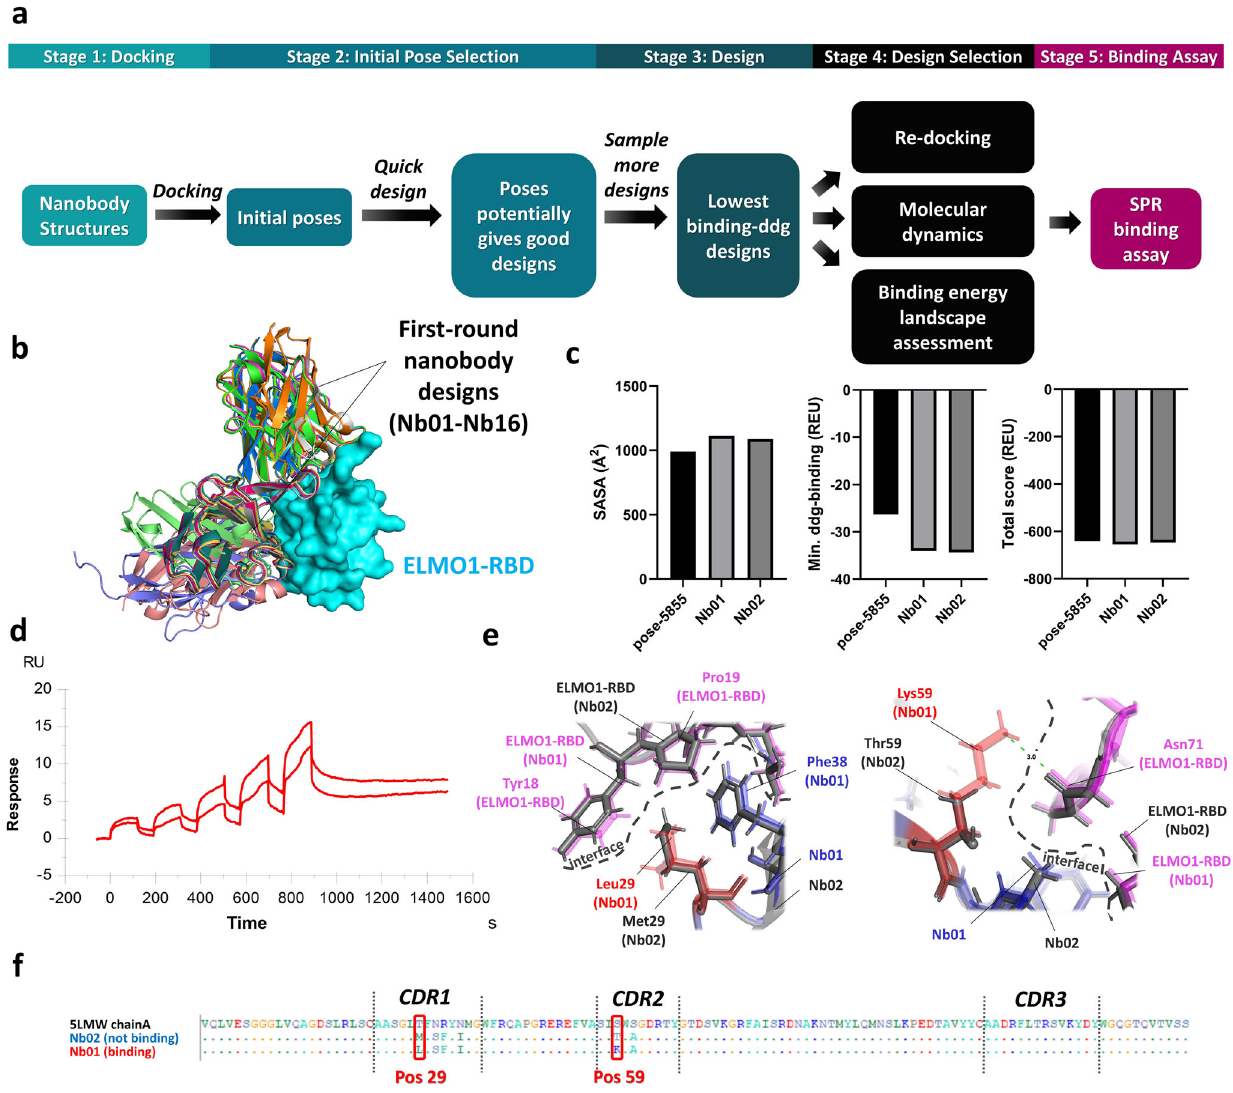
Fig. 2 Computational design and experimental veri fi cation results from fi rst-round design. a Overall design work fl ow in fi rst-round design. b Superposition of fi rst-round nanobody designs revealed the stabilization of two clusters of binding poses on two distinct epitopes on ELMO1-RBD. c Rosetta energy scores and buried solvent accessible area comparisons between designs Nb01, Nb02 and pose-5855. d SPR single-cycle kinetics of Nb01 binding to ELMO1-RBD. Nb01 was tested at concentrations of 0.5, 1, 2, 4, and 8 μ M from left to right ( n = 2 independent experiments). e Comparison of side chain interactions at position 29 and 59 between Nb01 and Nb02 at their interfaces with ELMO1-RBD. f Comparison of design mutations between Nb01 and Nb02 with reference to the sequence of parent nanobody PDB 5 LMW. Dots represent the same residue type as the parent nanobody at the aligned